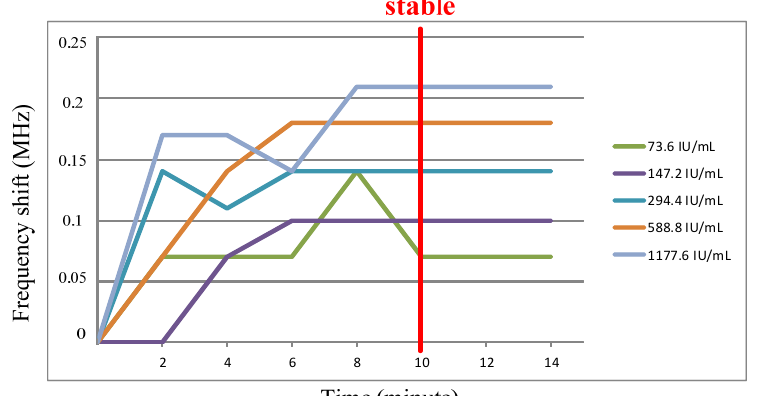
Figure 21. Frequency shift of the FPW allergy biosensor coated different IgE concentrations in human